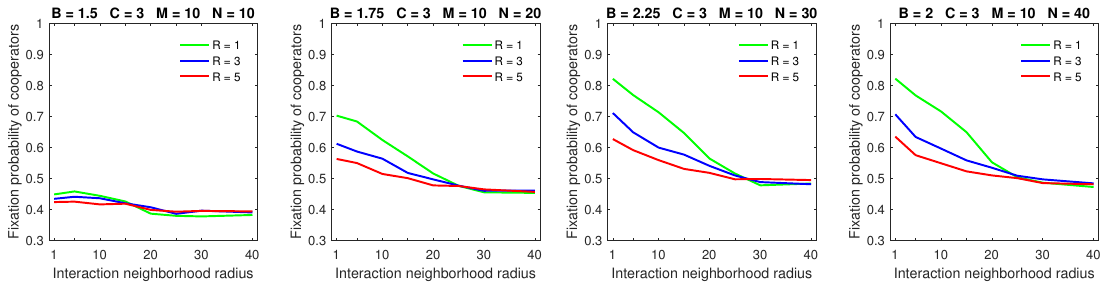
Figure 3. Increasing the dispersal range for high mobility rate M = 10 flattens the fixation probability curves in the almost deterministic dispersal model.